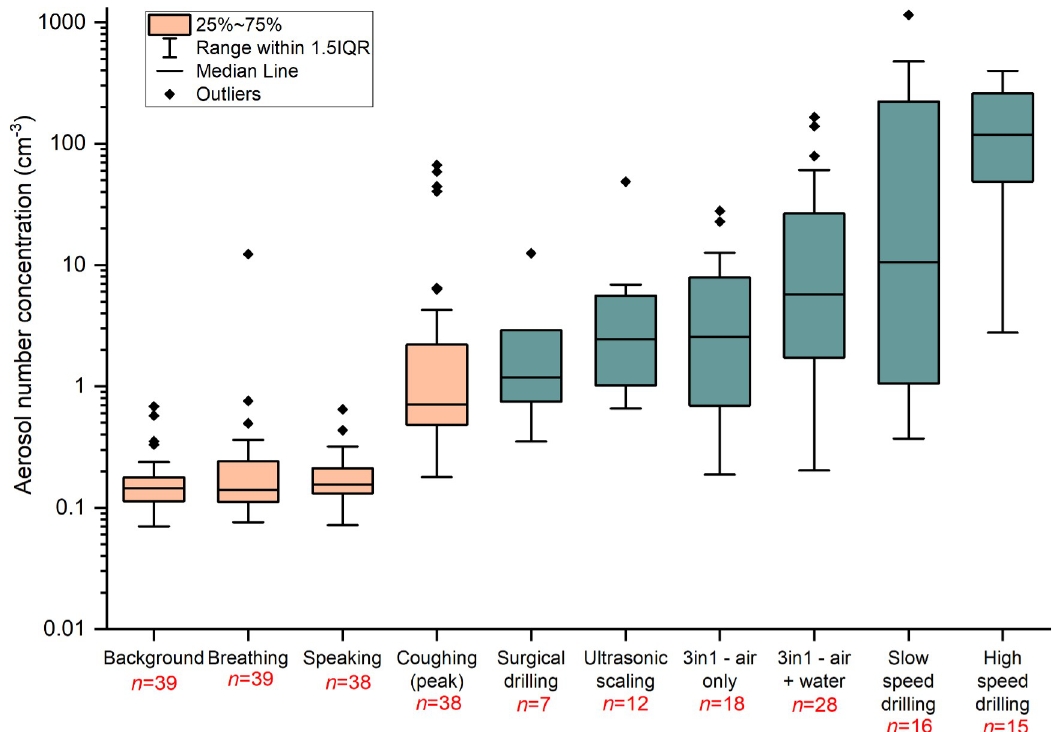
Fig 2. Box and whiskers plot of total aerosol number concentration for baseline measurements (orange) and dental procedures for which aerosol was detected above mean background value (green). The aerosol number concentration is reported on a logarithmic